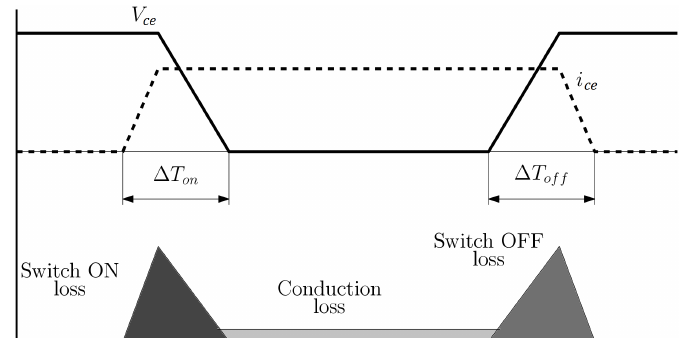
Figure 6. Diagram of a typical switching operation of a power switch that illustrates the (non-ideal) switching and conduction phases and the power losses related to each